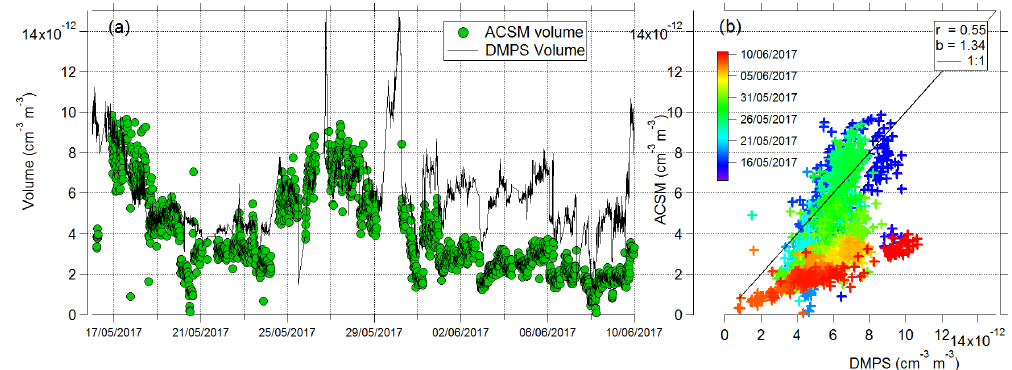
Figure 3. Comparison between the ACSM and the DMPS volume concentration (cm − 3 , m − 3